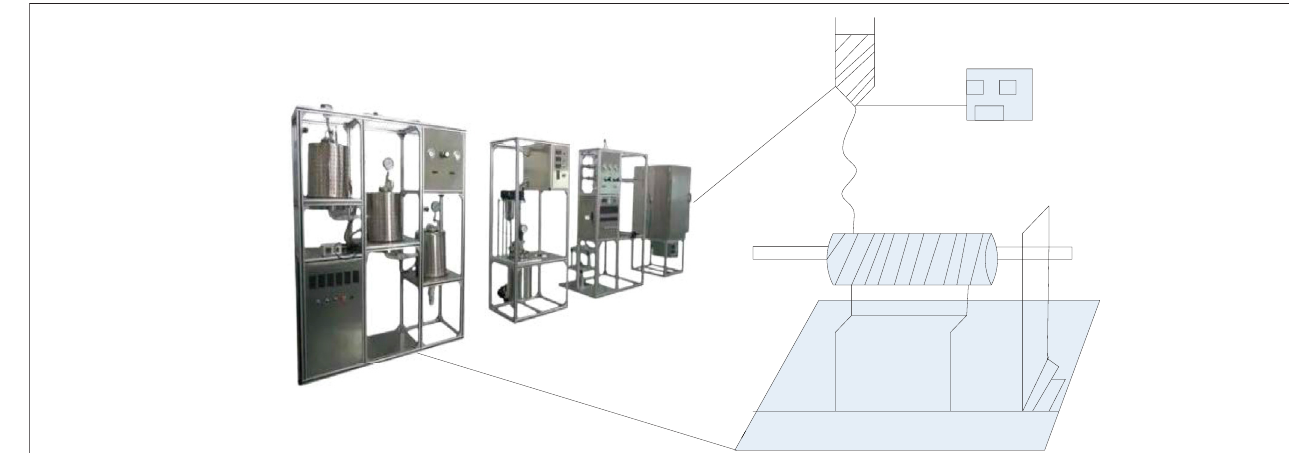
FIGURE 8 | Equipment diagram of electrospinning device.